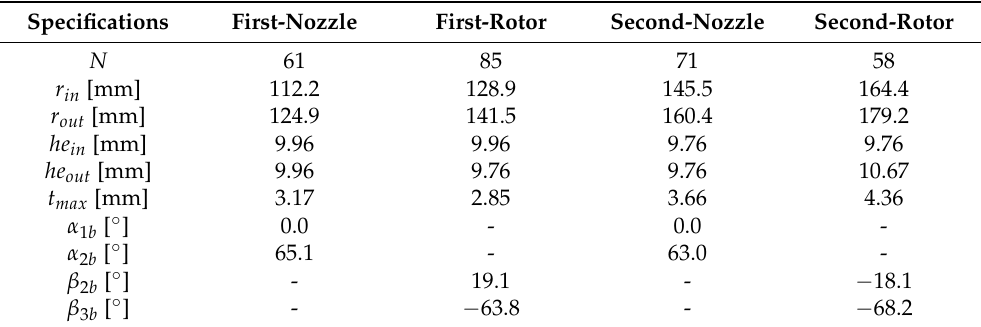
Table 3. Specifications of the two-stage radial outflow turbine according to the preliminary